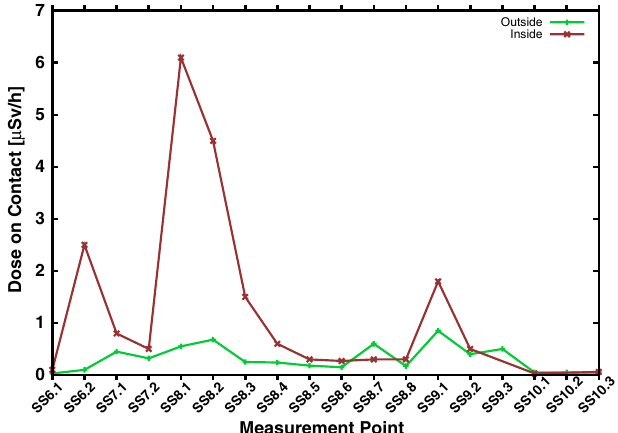
FIG. 17. Dose measurements on contact in several points along SS06 to SS10. In red, doses measured towards inside the ring; in green, towards outside. Losses occur mainly inwards the ma- chine in consistency with simulations in Fig. 16.